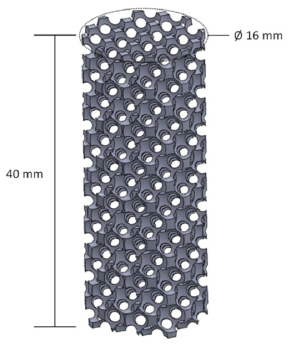
Figure 3. Prototype metal foam structure and final dimensions.